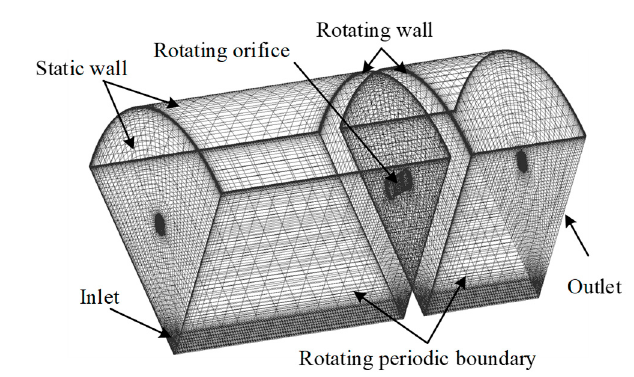
Figure 8. Overall grids of the rotating orifice with a Euler angle.